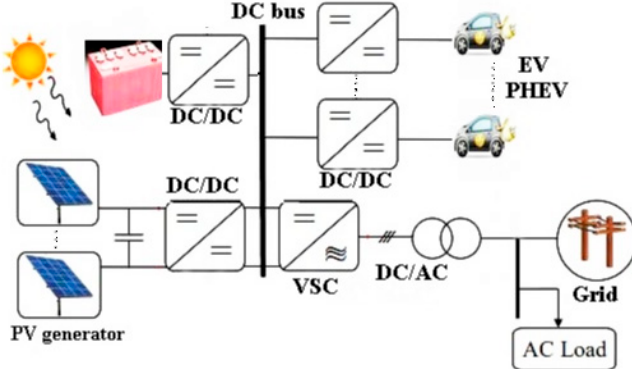
Figure 2. Schematic diagram of the solar energy system. PV: Photovoltaic, EV: Electric vehicle, VSC: Voltage Sourced Converter, PHEV: Plug-in hybrid electric vehicles, DC: Direct current and AC: Alternating current.